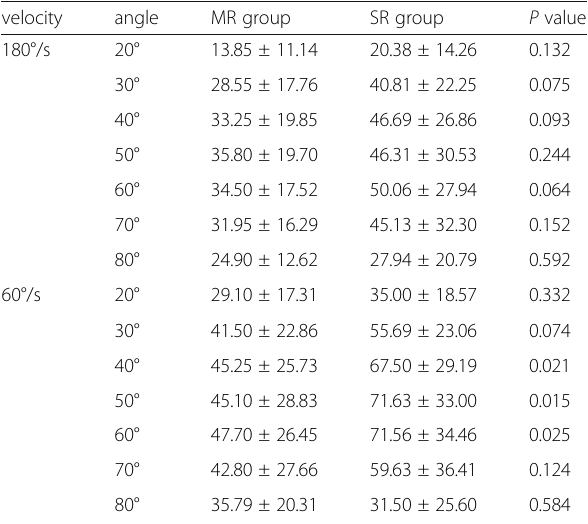
SD standard deviation, SR single radius, MR multiple radius